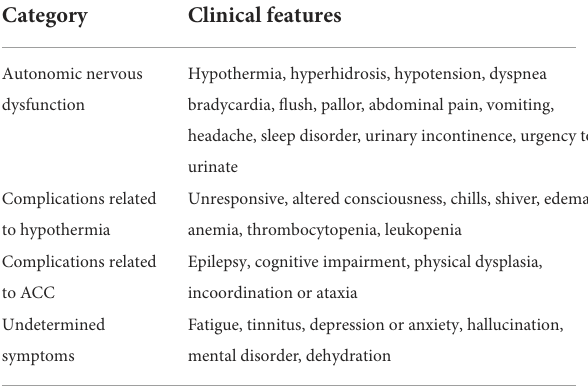
TABLE 2 Clinical features of Shapiro’s